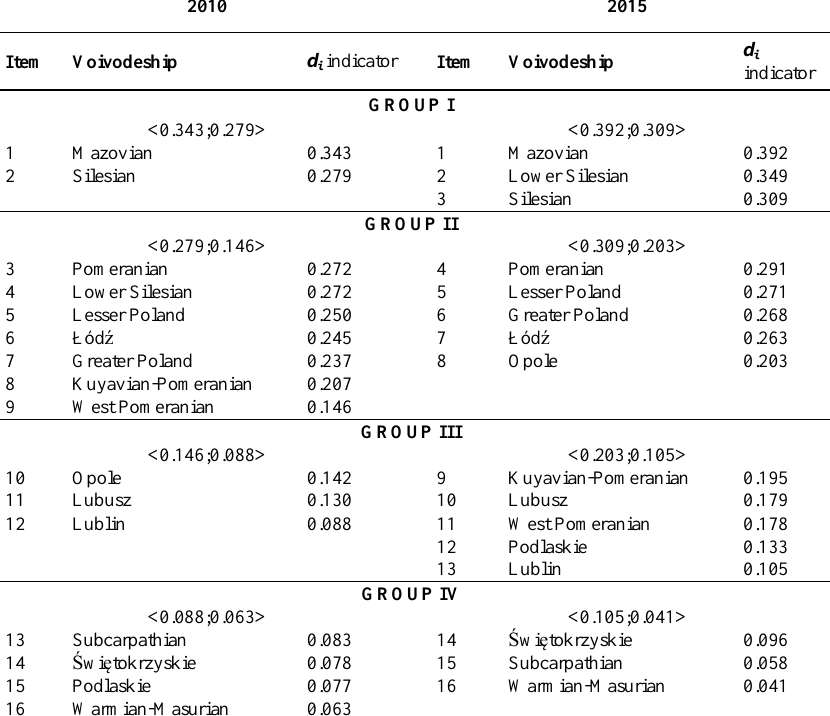
Table 2. The social and economic development level in Polish regions in the years 2010 and 2015 on the basis of Hellwig’s taxonomic development measure (according to Jenks’ Natural Breaks